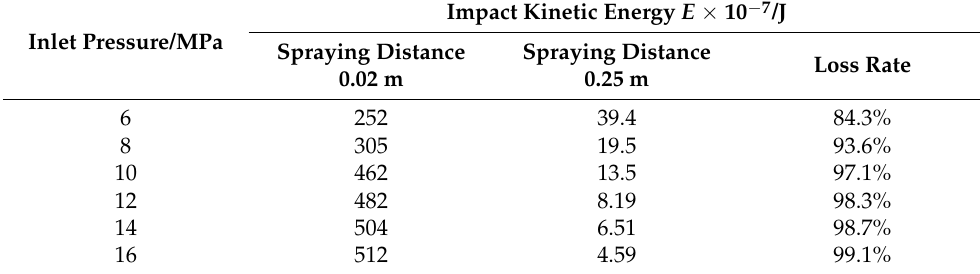
Table 7. Variation rate of droplet impact kinetic energy E.